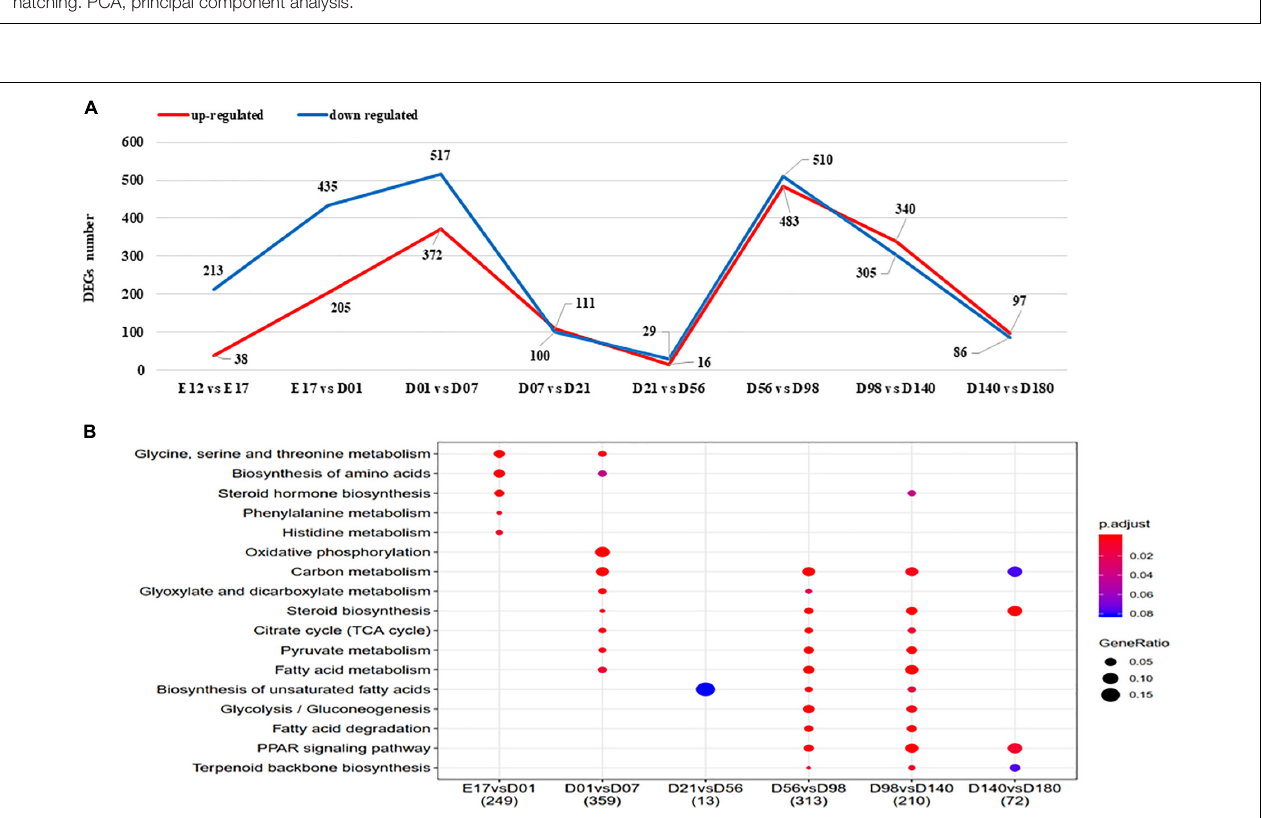
FIGURE 3 | (A) The DEGs between adjacent stages of liver. Upregulated and downregulated gene number shown in red and blue, respectively. (B) The KEGG enriched pathways of DEGs between adjacent stages. DEGs, differentially expressed genes; KEGG, Kyoto Encyclopedia of Genes and